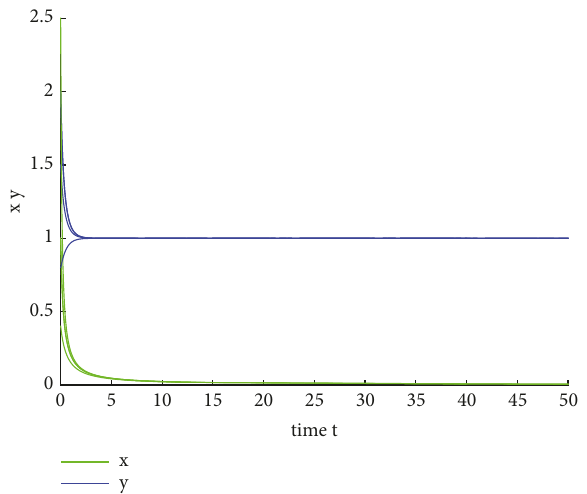
Figure 4: Solutions (𝑥(𝑡),𝑦(𝑡)) of system (24) with the initial conditions (𝑥(0),𝑦(0)) = (1, 2),(0.4,1.5) , and (2.5,0.8)